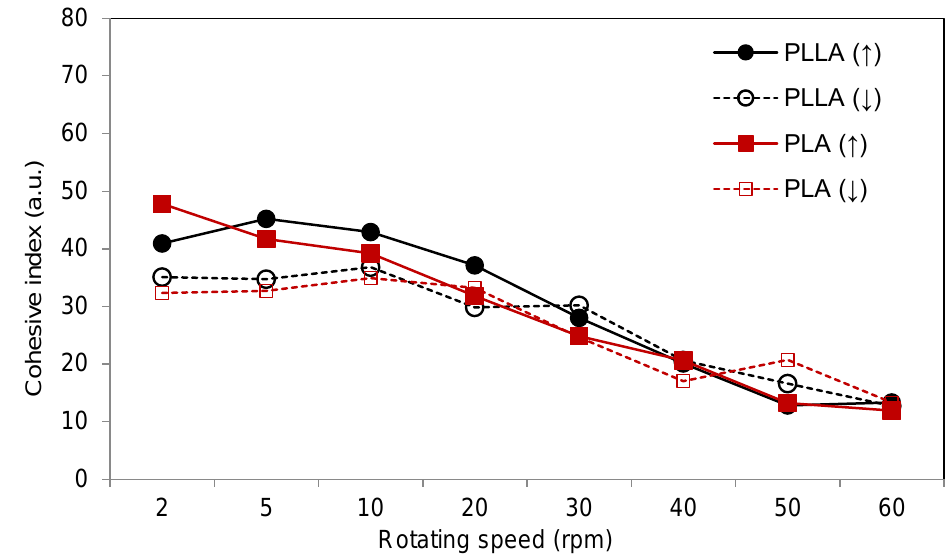
Figure 3. Cohesive index curves recorded as a function of the increasing ( ↑ ) and decreasing ( ↓ ) rotation speed for PLA and PLLA powders.